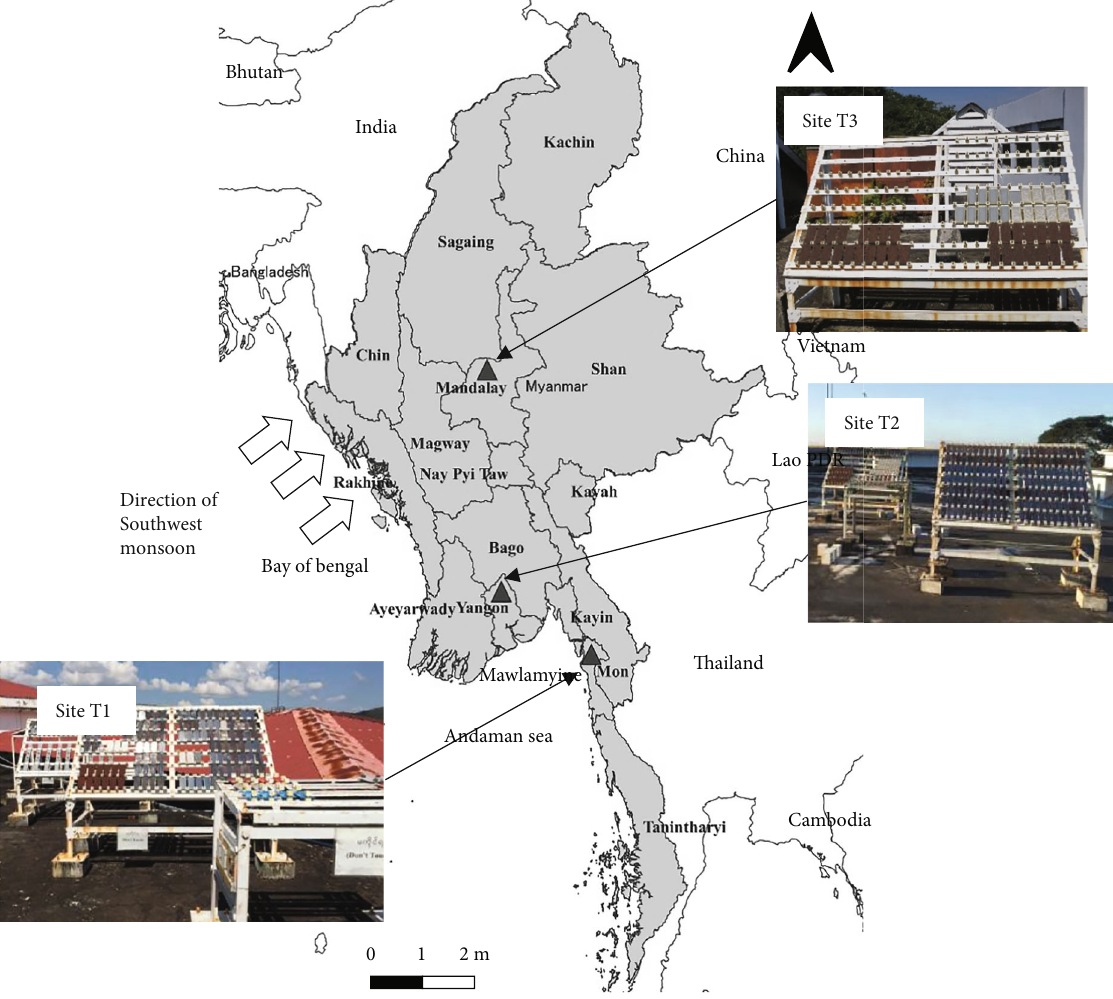
Figure 1: Locations of test